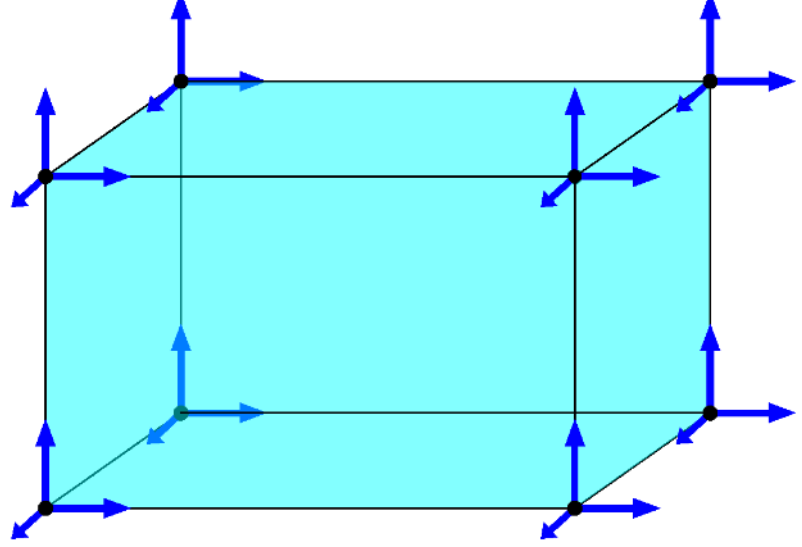
Figure 8. Shape of the three-dimensional element used in the FEM calculation. Deformation vector of a three-dimensional